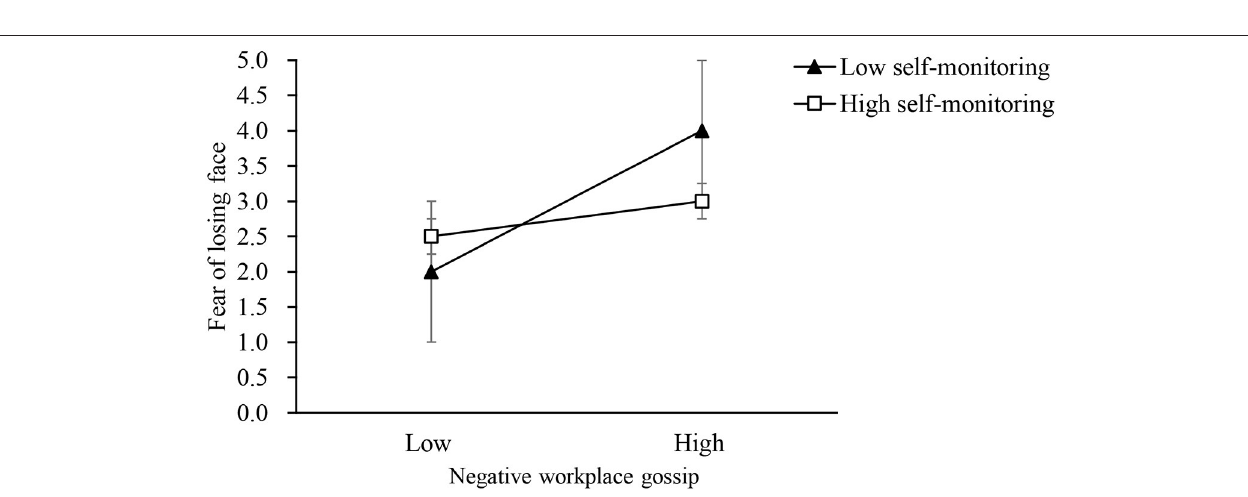
FIGURE 1 | Theoretical model of the current research. Note: Negative workplace gossip and self-monitoring were both measured at time point 1, fear of losing face was measured at time point 2, and engaging in negative gossip was measured at time point 3.